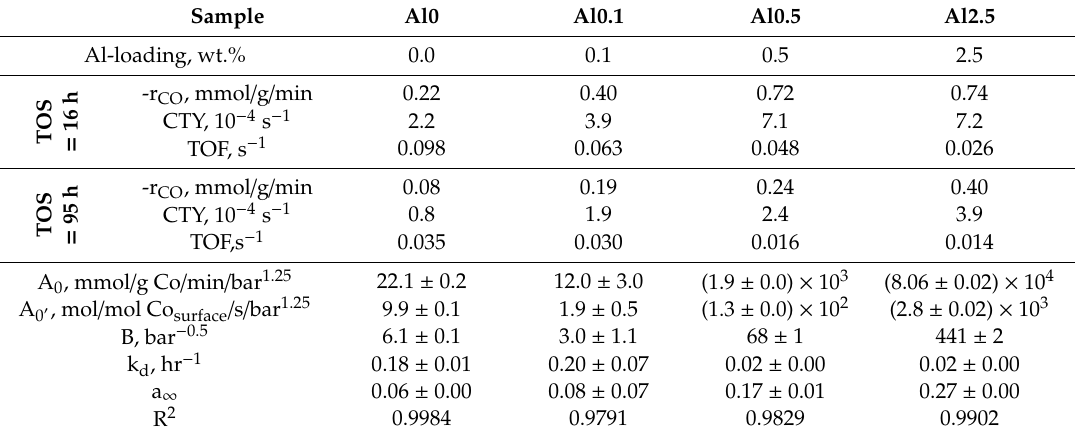
Table 2. Initial activity and deactivation in the Fischer–Tropsch synthesis at 220 ◦ C and 20